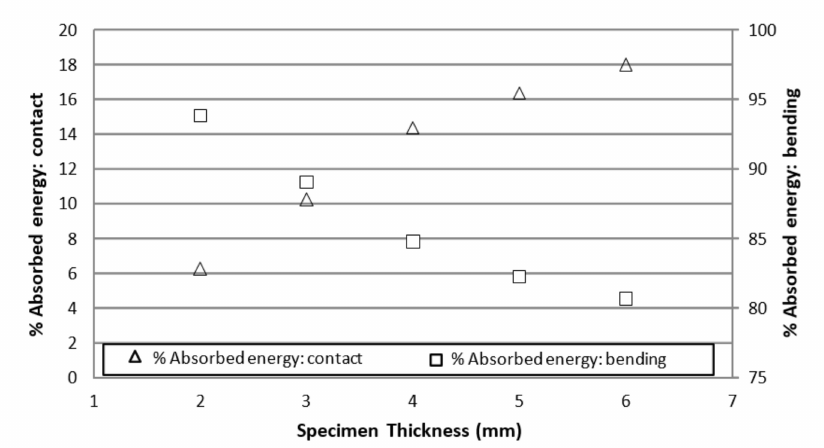
Figure 13. Percentage of absorbed energy due to contact and bending as a function of the specimen thickness. Data in Figures 11–13 could be fitted by third-order function. The flexural stiffness and compliance of an edge-clamped plate is related with the cubic power of the thickness